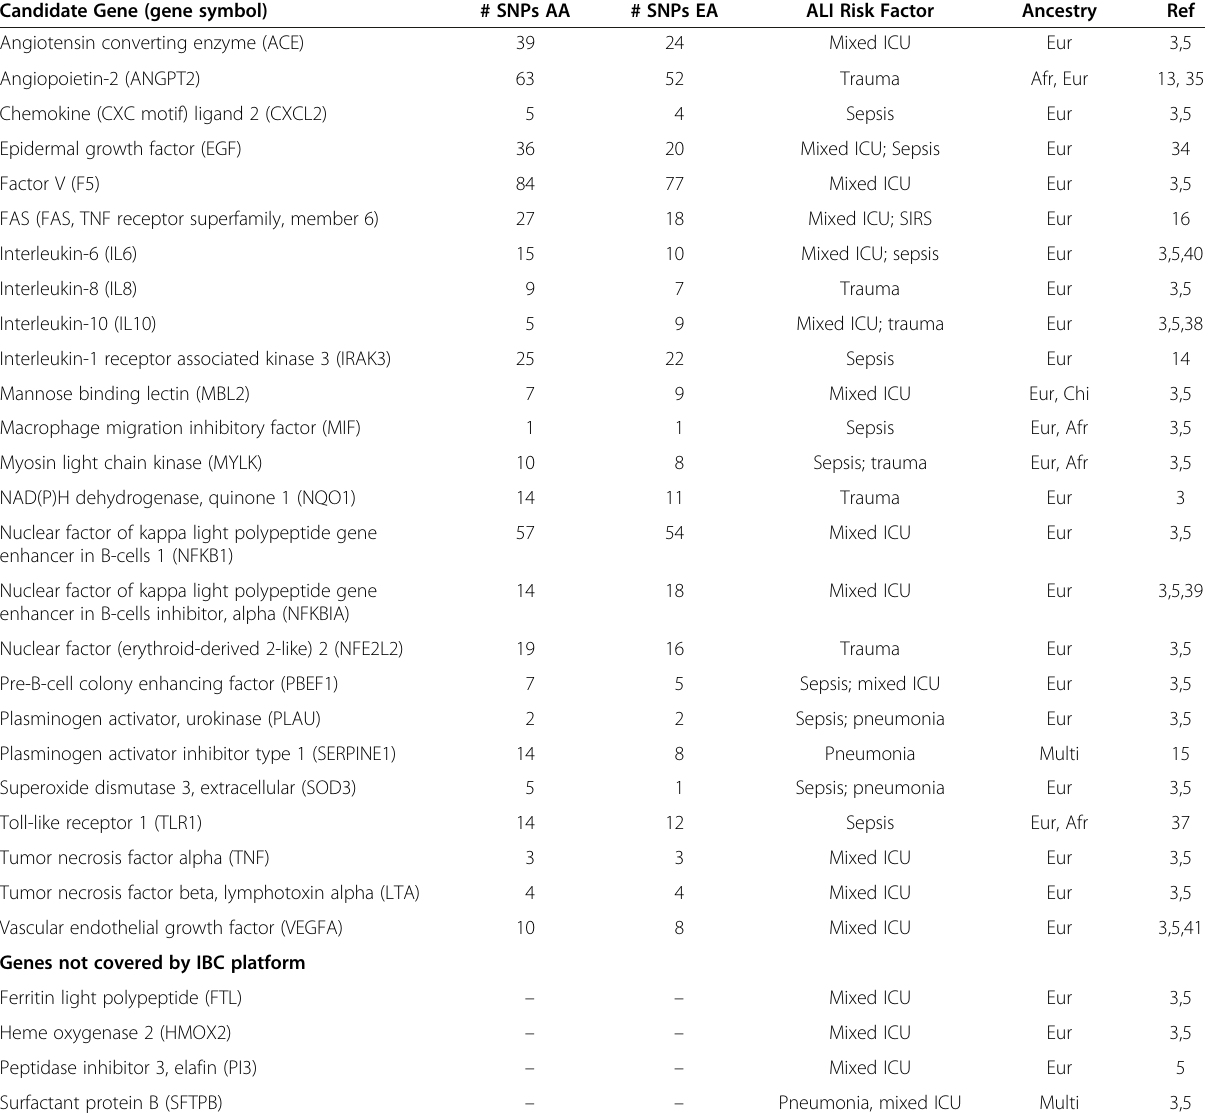
Table 2 Candidate Gene list